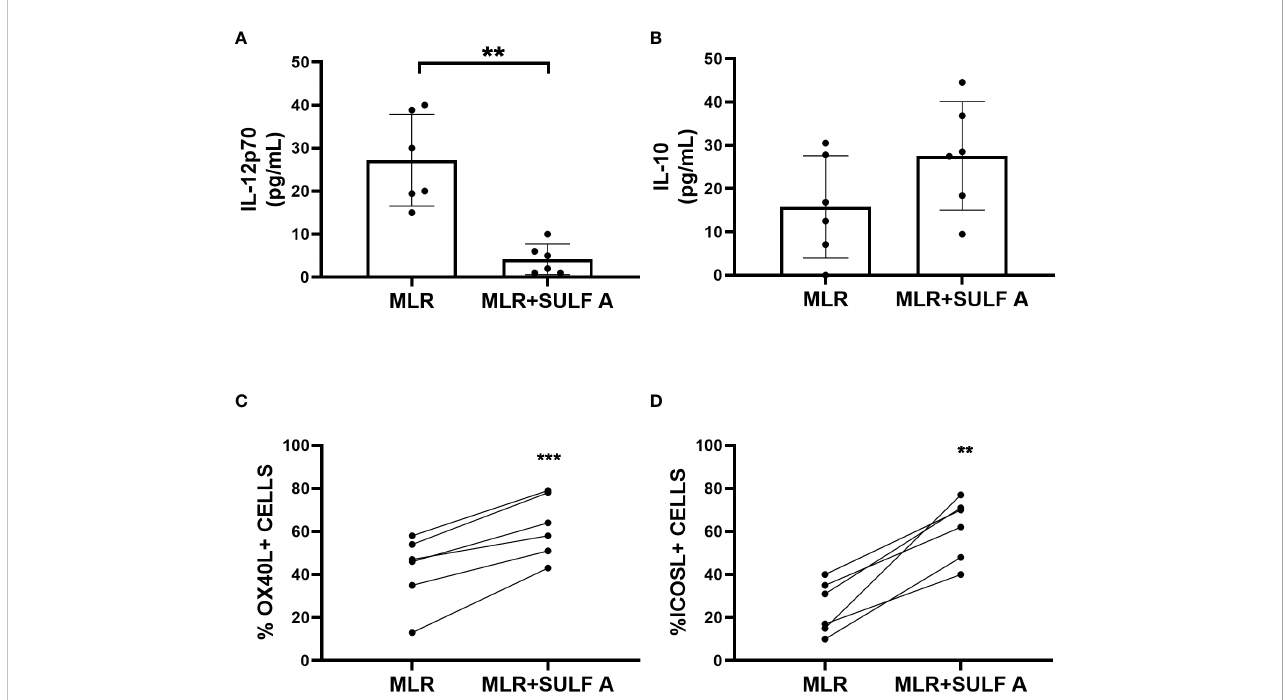
FIGURE 2 Response of cultured MoDCs with naïve T lymphocytes 48h after addition of SULF A. (A – B) Levels of cytokines IL-12 and IL-10 in supernatants measured by ELISA assay; (C – D) Surface expression of the costimulatory molecules OXO40L and ICOSL of live CD11c+/CD3- DCs measured by FACS. The gating strategy used for these markers is reported in Supplementary Figure 3. MLR= untreated co-cultures; MLR+SULF A= co-cultures treated with 10 m g /mL SULF A. Statistical analysis (n = 6) was performed by paired non parametric two tailed T test. * P < 0.05; *** P < 0.001.